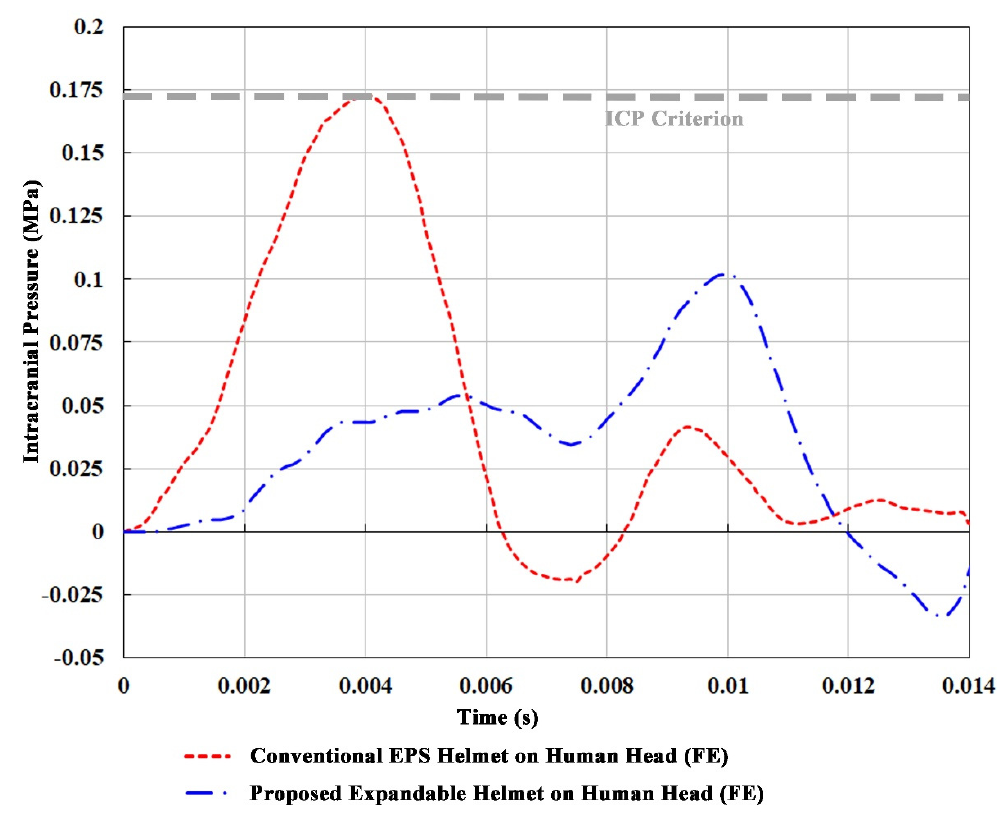
Figure 5. The intracranial pressure (ICP) histories at the mid-brain region of the head model for the EPS helmet and the proposed expandable helmet.